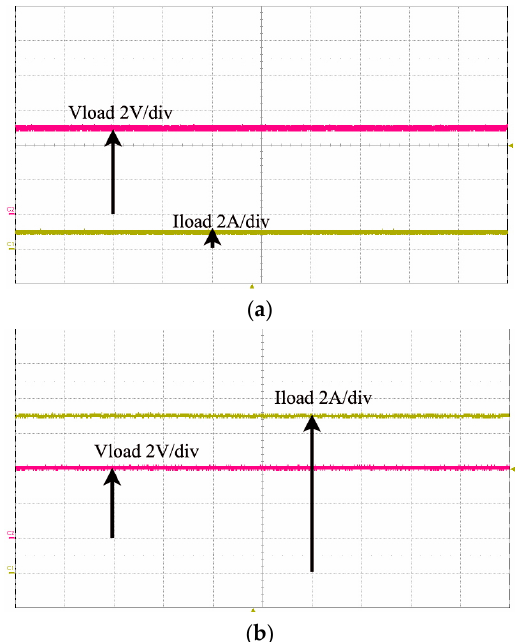
Figure 18. Constant current sink test ( a ) 10% load current (1 ms/div), ( b ) 100% load current (1 ms/div).